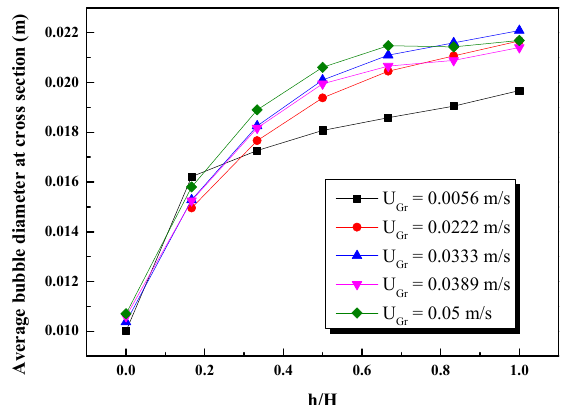
Figure 16. Average bubble diameter at different cross sections for various U Gr at a total column height of 15 m.